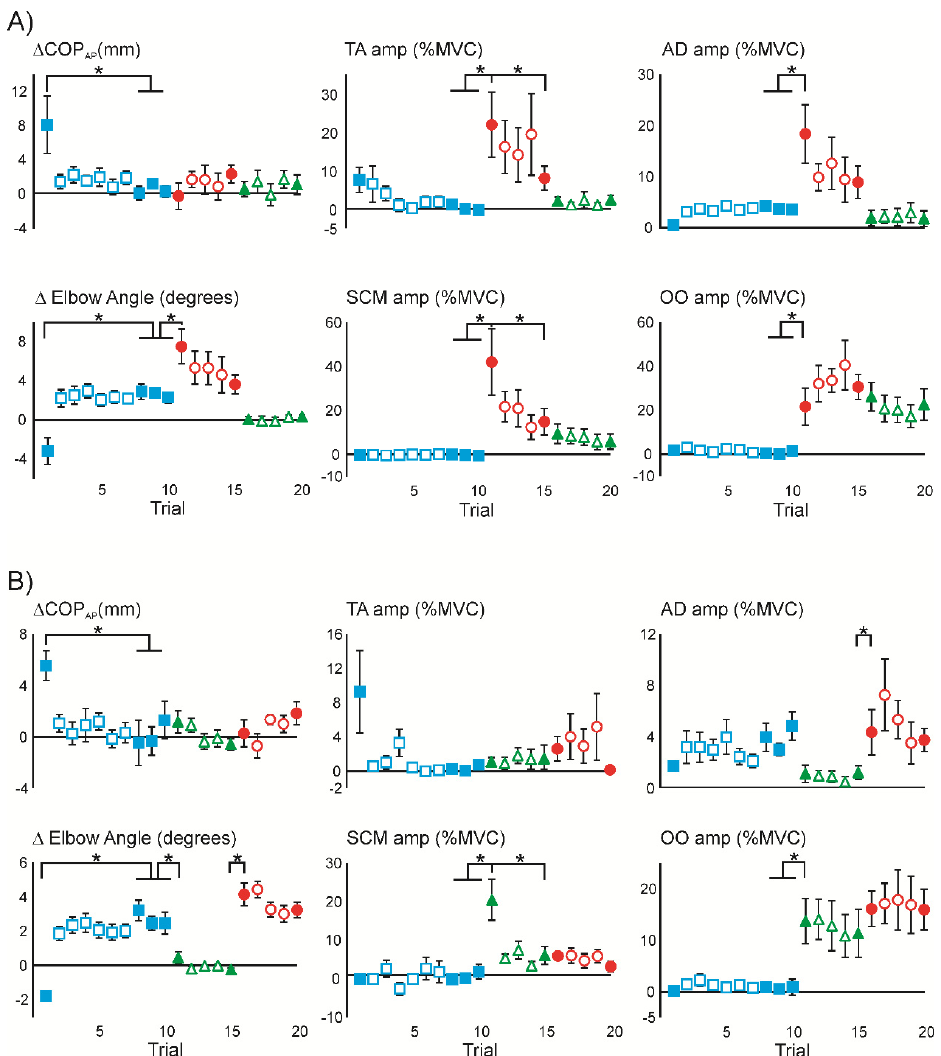
Figure 3. Trial-by-trial mean (SE) mechanical and muscle response amplitudes for participants who habituated to the DISPLACEMENT stimuli initially. ( A ) Participants subsequently received the COMBINED stimuli, followed by the STARTLE. ( B ) Participants subsequently received the STARTLE, followed by the COMBINED stimuli. Asterisks indicate differences identified by Tukey’s HSD comparisons ( p < 0.05). Blue squares, DISPLACEMENT; Red circles, COMBINED; Green triangles, STARTLE. Closed symbols indicate data points used in the statistical analysis. TA, tibialis anterior; AD, anterior deltoid; SCM, sternocleidomastoid; OO, orbicularis oculi; COP AP , center of pressure anterior–posterior; MVC, maximum voluntary contraction.